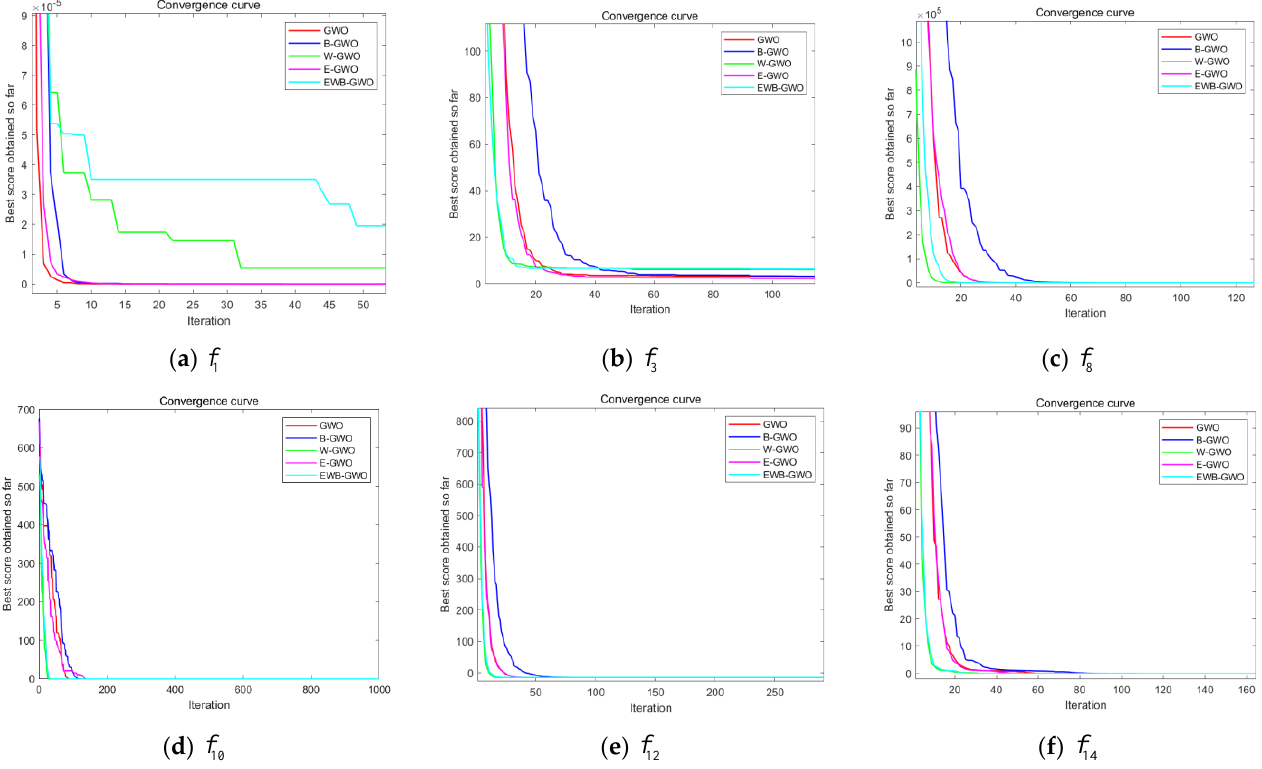
Figure 10. Comparison of convergence curves of GWO, E − GWO, W − GWO, B − GWO, and EWB − GWO with Dim = 50.